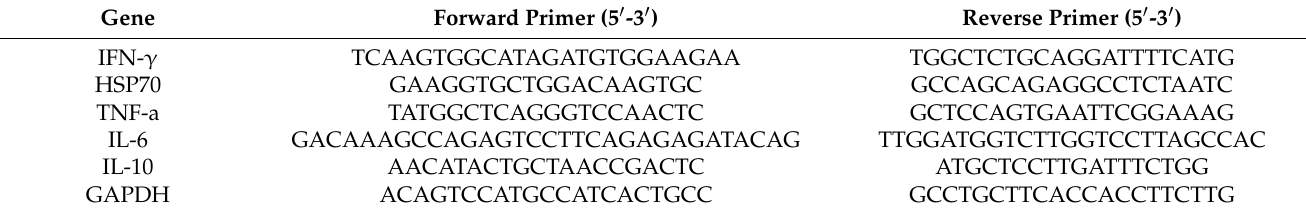
Table 1. Primers used for